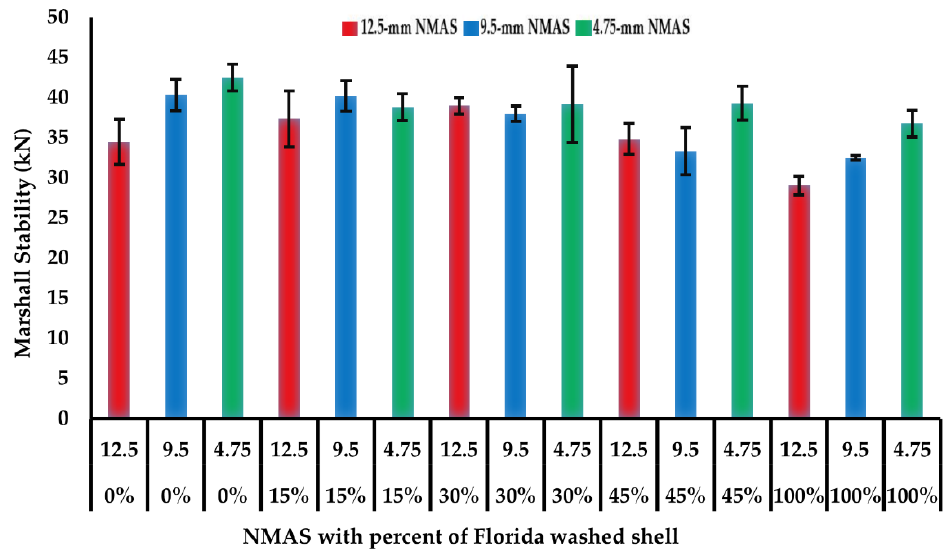
Figure 3. Marshall stability results of open-graded asphalt mixtures at 25 ◦